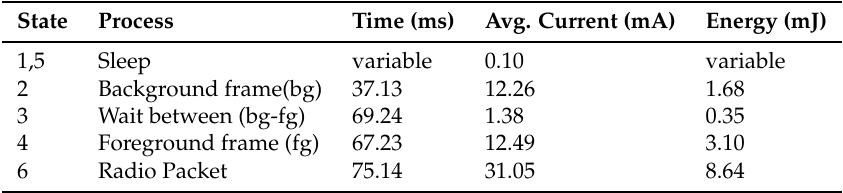
Table 3. Current composition split into different states of operation for DASH7 background and foreground scanning.